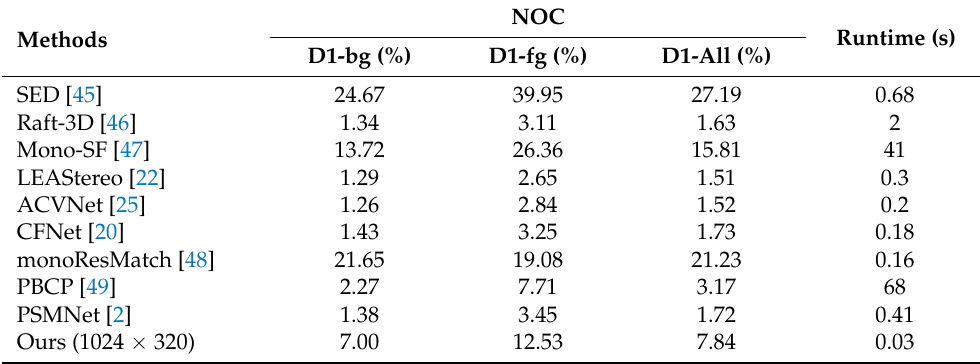
Table 3. Comparison of stereo matching methods on the KITTI stereo 2015